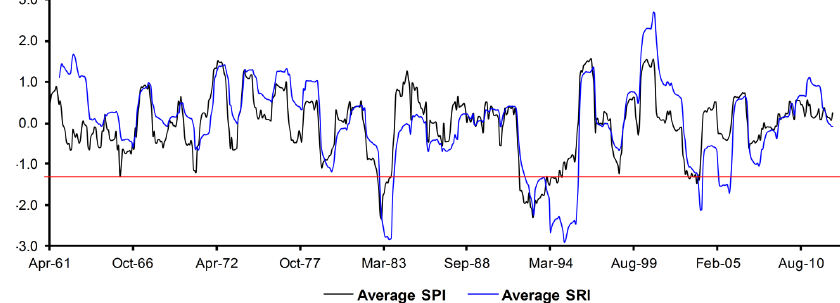
Figure 3. Average SPI and SRI (12-month scale).